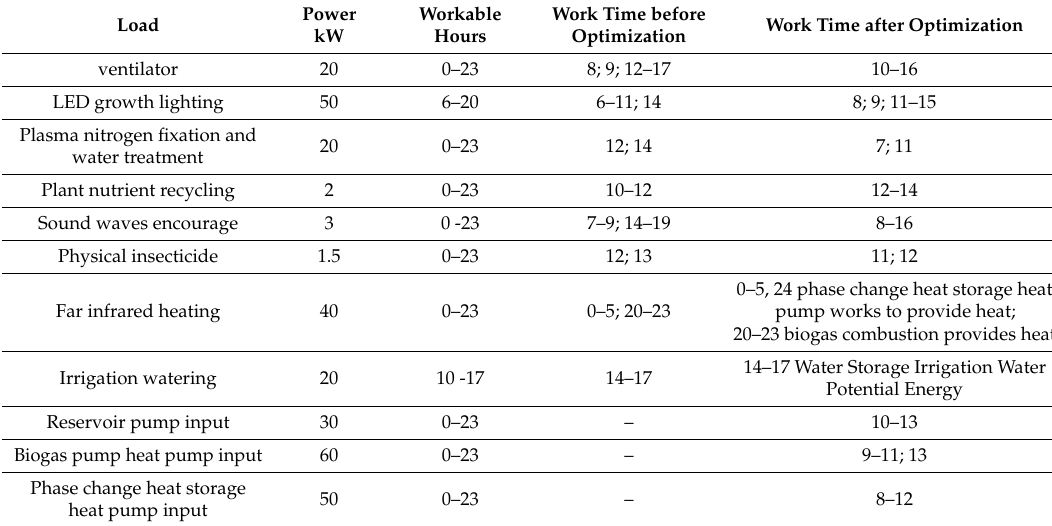
Table 2. Timetable of loads and energy storages working time before and after optimization on a sunny winter day.